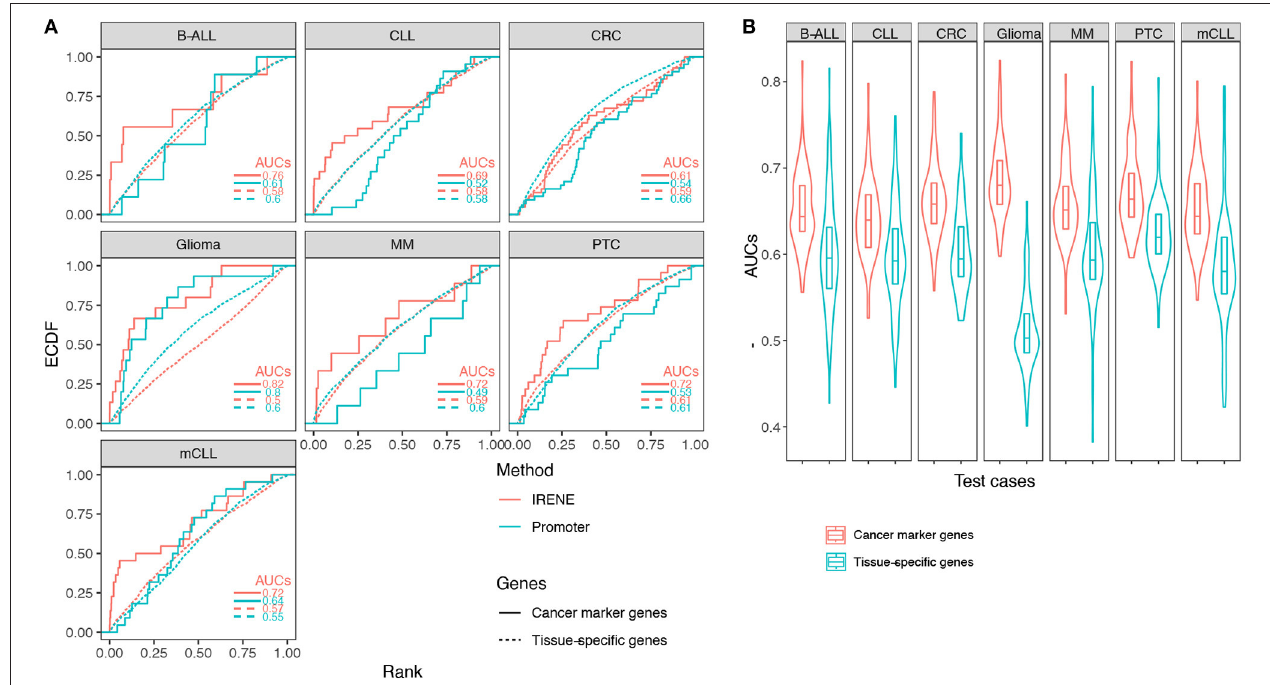
FIGURE 3 | (A) Empirical cumulative density function (ECDF) curves regarding the cancer marker genes and tissue-specific genes in seven test cases. The marker gene ranks using IRENE scores (red) are compared against their ranks using the promoter scores (cyan). (B) Distribution of the area under the curve (AUC) values using the cancer marker gene (CMG) sets from CancerMine in the seven test cases, compared to randomly picked tissue-specific genes to define equal size sets.